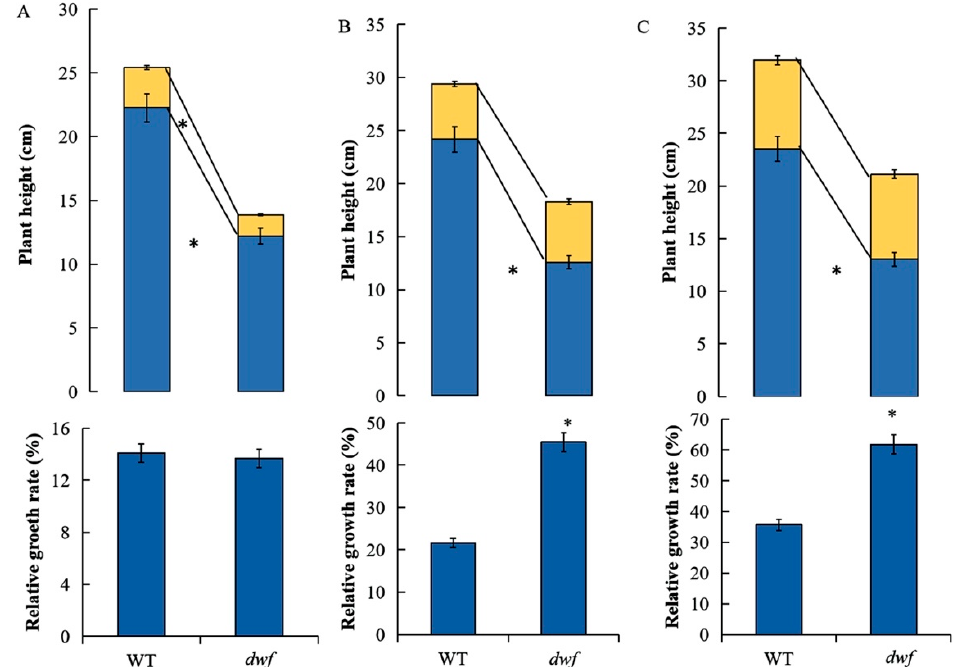
Figure 5. Effect of exogenous GA 3 treatment on plant growth. ( A ) Treatment with water. ( B ) Treatment with 100 mg/L